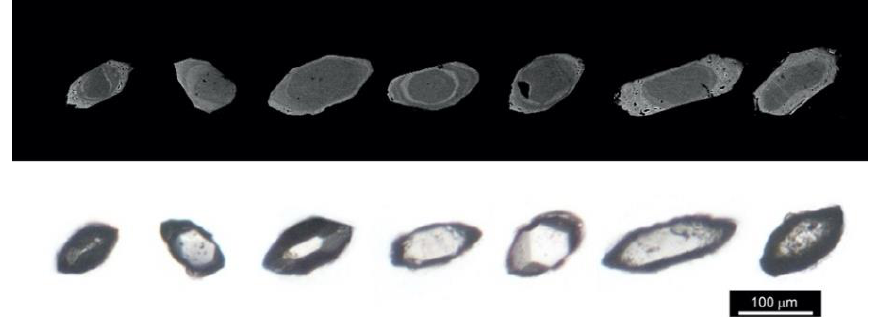
Figure 8. BSE images and optical photomicrographs of analysed zircons from tb-07-845 sample (migmatite). Ellipses mark analytical spot locations and the text shows spot names (italics) and 208 Pb/ 236 U age in Ma (bold).